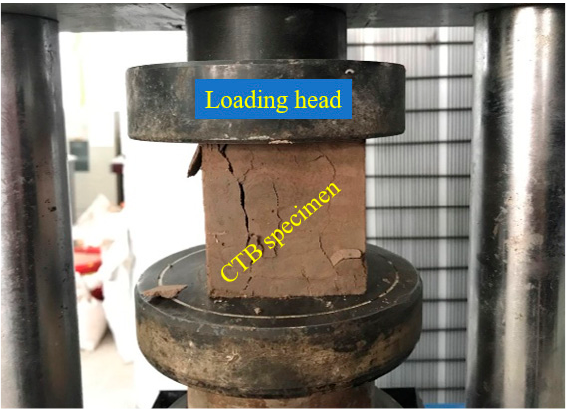
Figure 6. A cubic CTB sample subjected to the unconfined compressive strength (UCS) test.